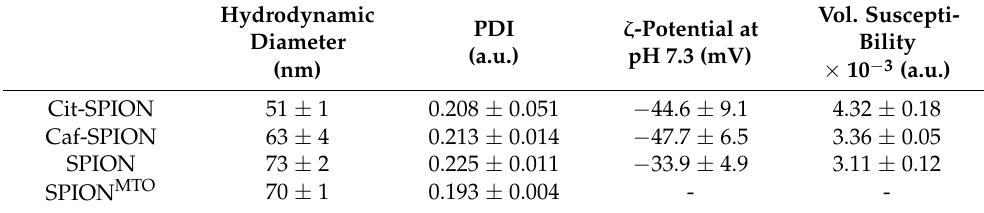
Table 2. Summary of the physicochemical parameters for the used SPION systems. Vol. Suscepti- Hydrodynamic ζ -Potential at PDI Bility Diameter (a.u.) pH 7.3 (mV) × 10 − 3 (a.u.) (nm) Cit-SPION 51 ± 1 0.208 ± 0.051 − 44.6 ± 9.1 4.32 ± 0.18 Caf-SPION 63 ± 4 0.213 ± 0.014 − 47.7 ± 6.5